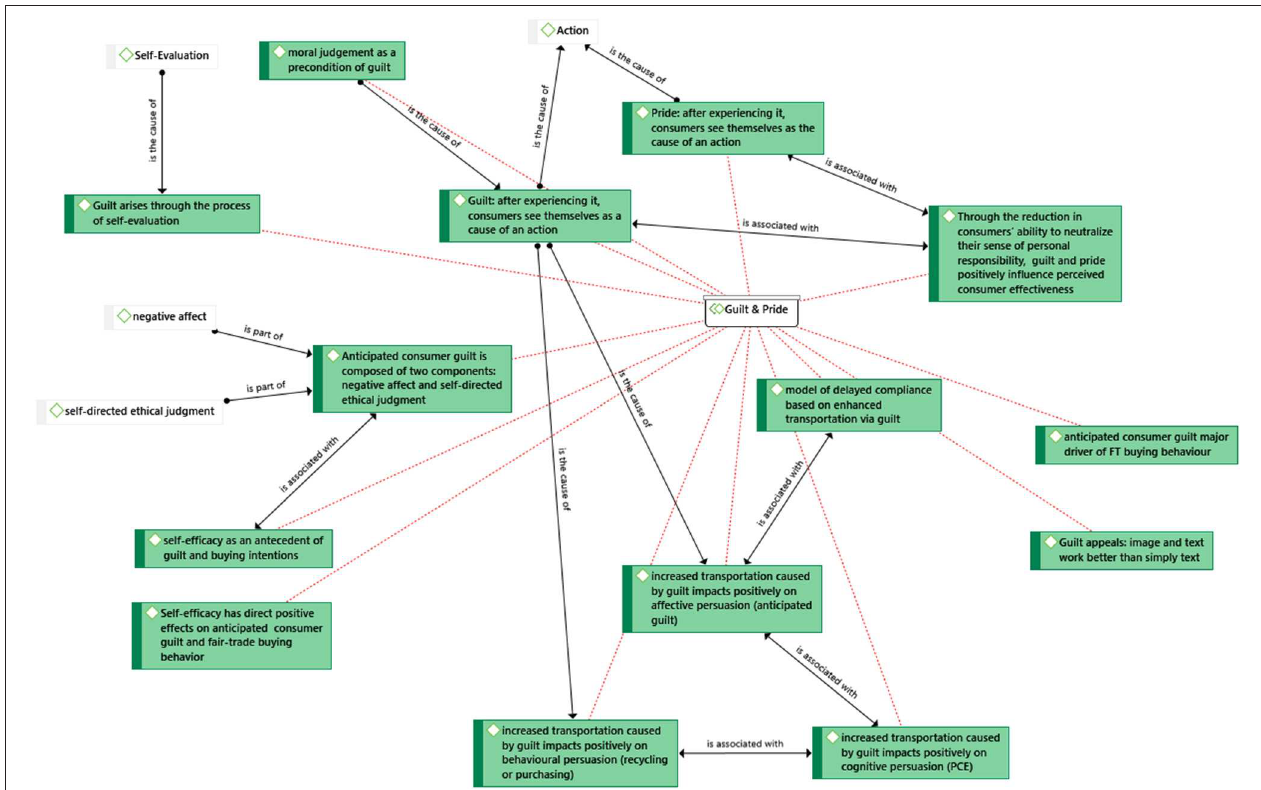
FIGURE 4 | Network analysis: Guilt and